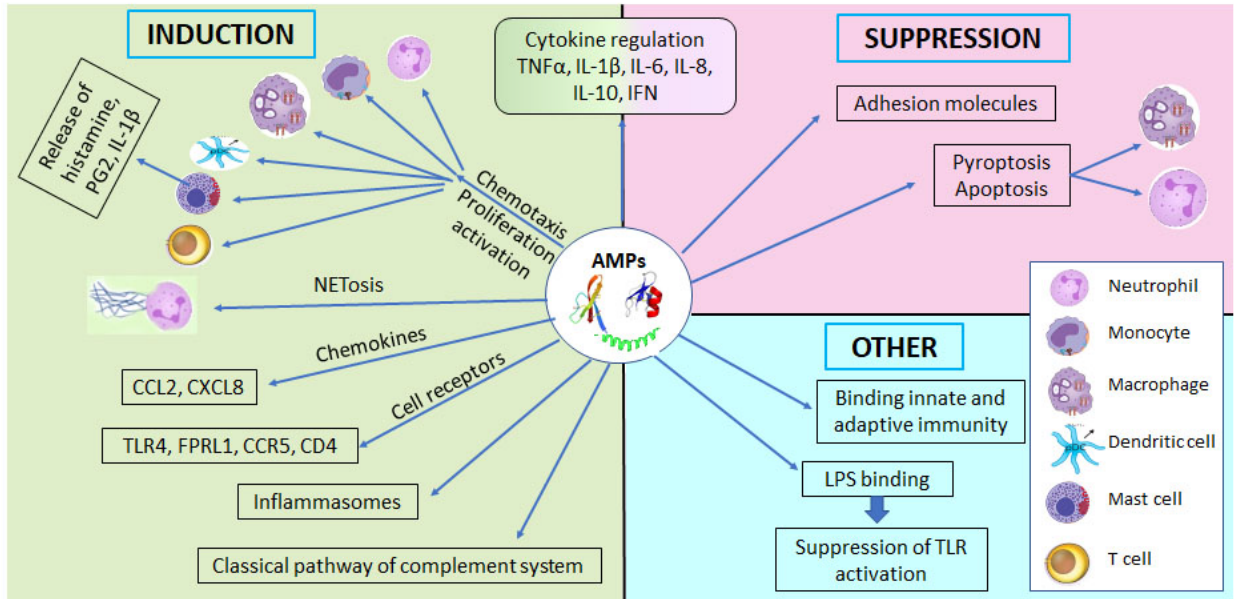
Figure 2. Summary of immunomodulating properties of antimicrobial peptides.